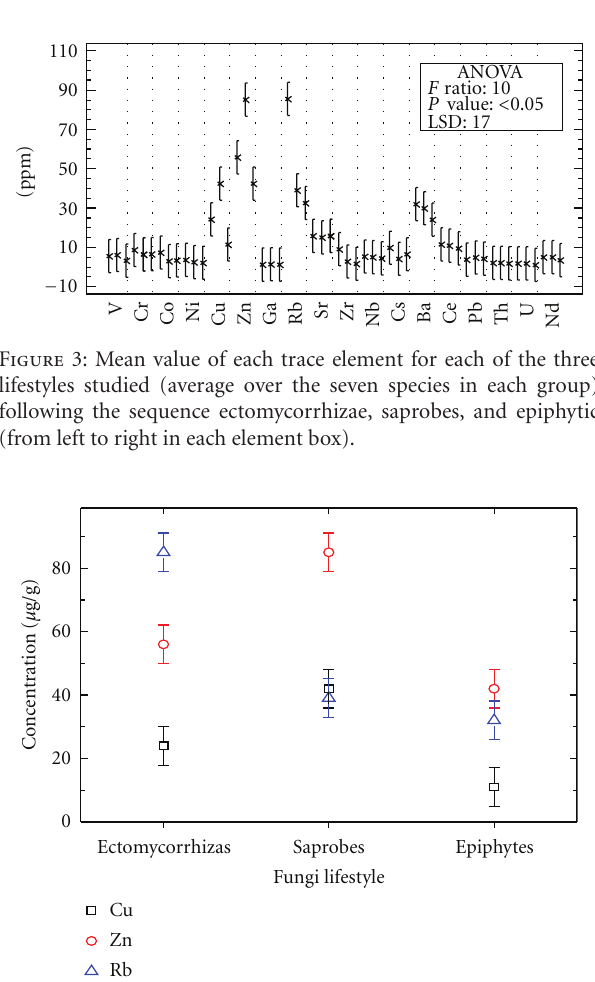
Figure 4: Mean content ( µ g · g − 1 DM ) of Cu, Zn, and Rb in each of the three lifestyles